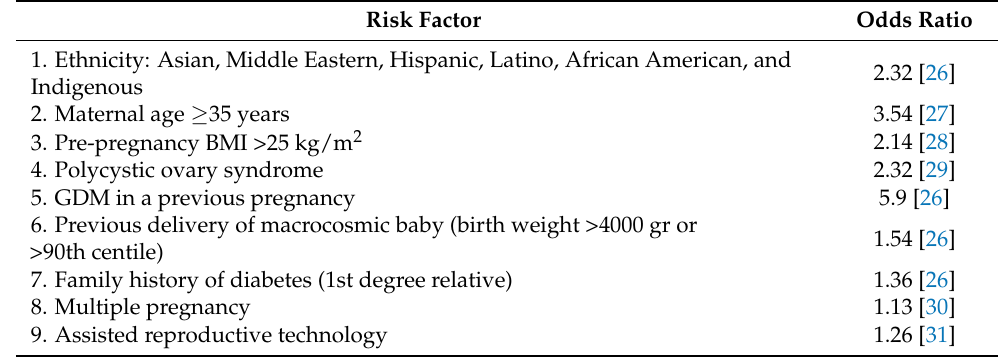
Table 1. Clinical risk factors with corresponding odds ratios for gestational diabetes